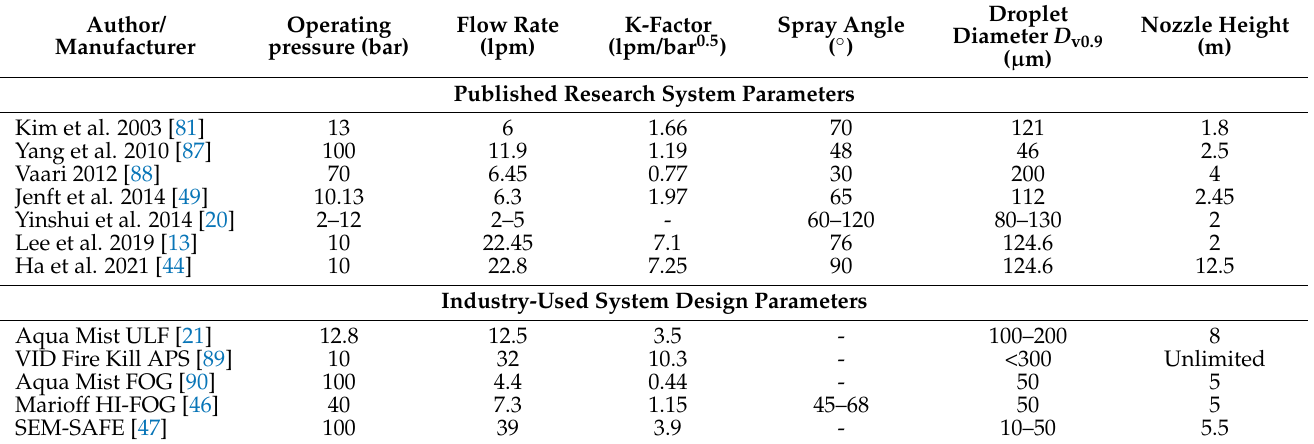
Table 3. Summary of various water mist parameters from existing research and available products.